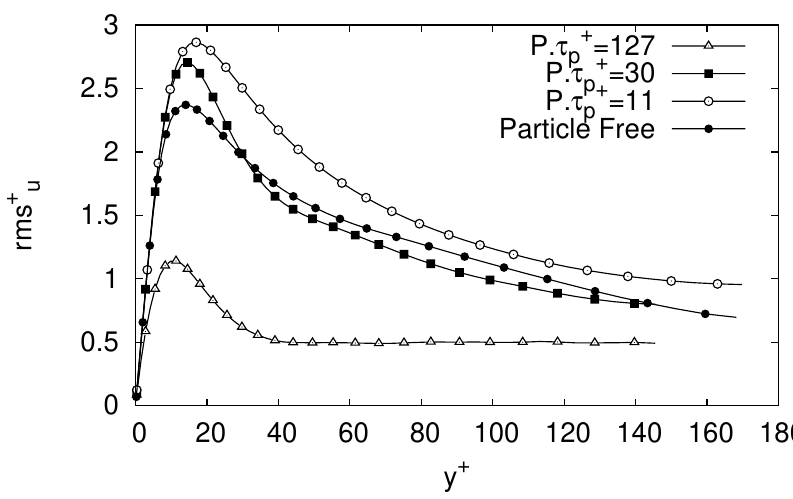
Figure 8. Comparison of rms + u profiles for all production cases.